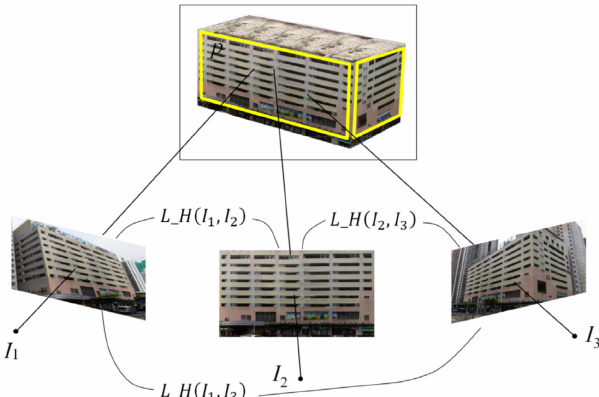
Figure 5. Multiview local homography transformation. I 1 , I 2 , I 3 denote three multiview candidate public images corresponding to the same building; p is a building façade. L _ H ( I 1 , I 2 ) , L _ H ( I 2 , I 3 ) , and L _ H ( I 1 , I 3 ) are the multiple local homography matrices of image pairs ( I 1 , I 2 ) , ( I 2 , I 3 ) , and ( I ) , 1 , I 3